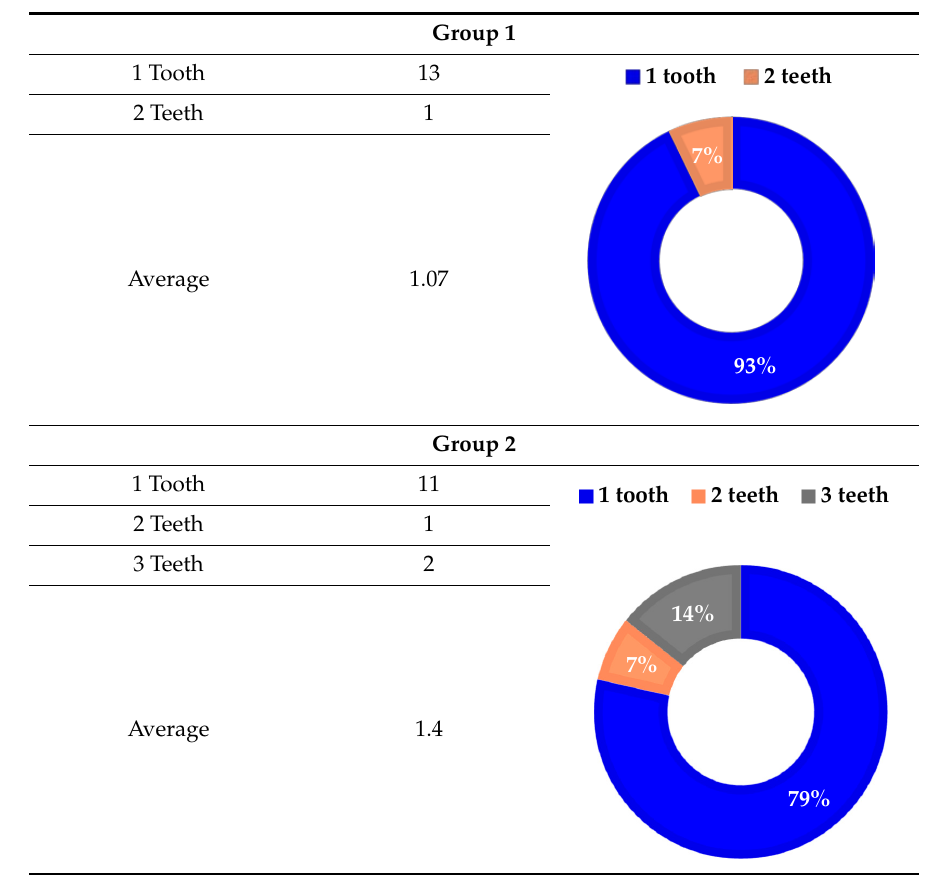
Table 4. Etiology for each extraction. Prosthetic